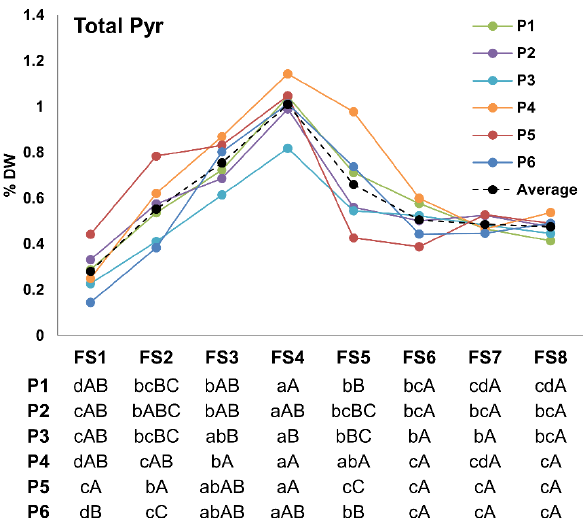
Figure 2. Content of total pyrethrin across the eight flower developmental stages in six Dalmatian pyrethrum populations. Lowercase letters refer to differences between phases in the same population, while uppercase letters refer to differences between populations within the same phase.